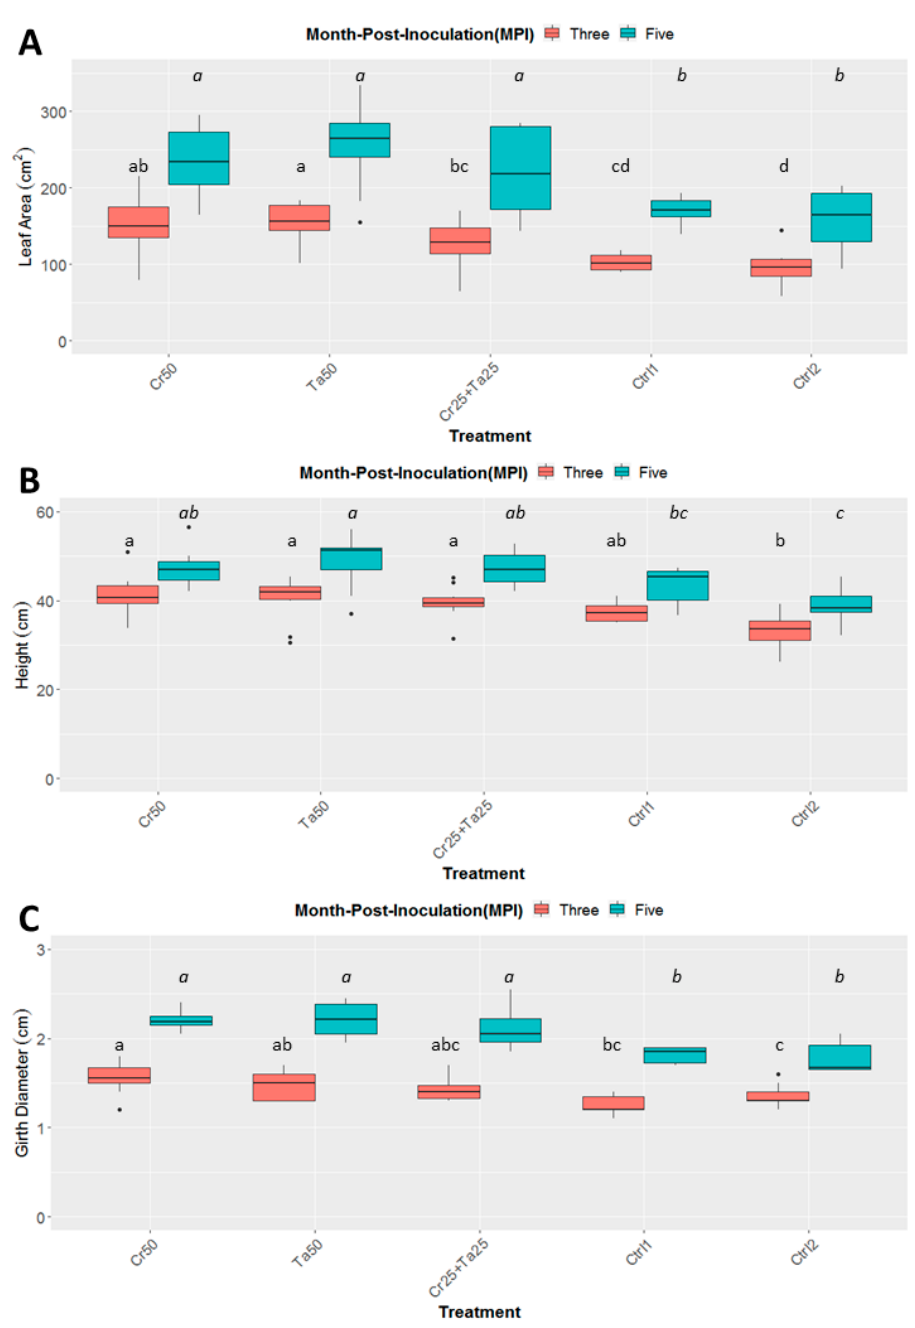
Figure 4. E ff ects of Ta and Cr , either applied individually or in consortium on the development and growth of oil-palm seedlings, namely leaf area ( A ), height ( B ), and diameter of the bole girth ( C ), 3 and 5 months post-inoculation (MPI). Treatments abbreviations: Cr50—inoculated with 50 g of C. rosea AAB0114 ( Cr ); Ta50—inoculated with 50 g of T. apiculatus AAT0115 ( Ta ); Cr25 + Ta25—inoculated with 25 g of Cr and 25 g of Ta ; control 1—only the uninoculated blended maize was applied; and control 2—without the uninoculated blended maize. Means of the three di ff erent vegetative growth parameters (VGM) at two separate recording time points (3 and 5 MPI) were analyzed separately. Means with the same letters for the all five treatments within 3 or 5 MPI for the respective VGM parameters were not significantly di ff erent with ANOVA–Fisher at p = 0.05. Numbers presented in the figures are untransformed